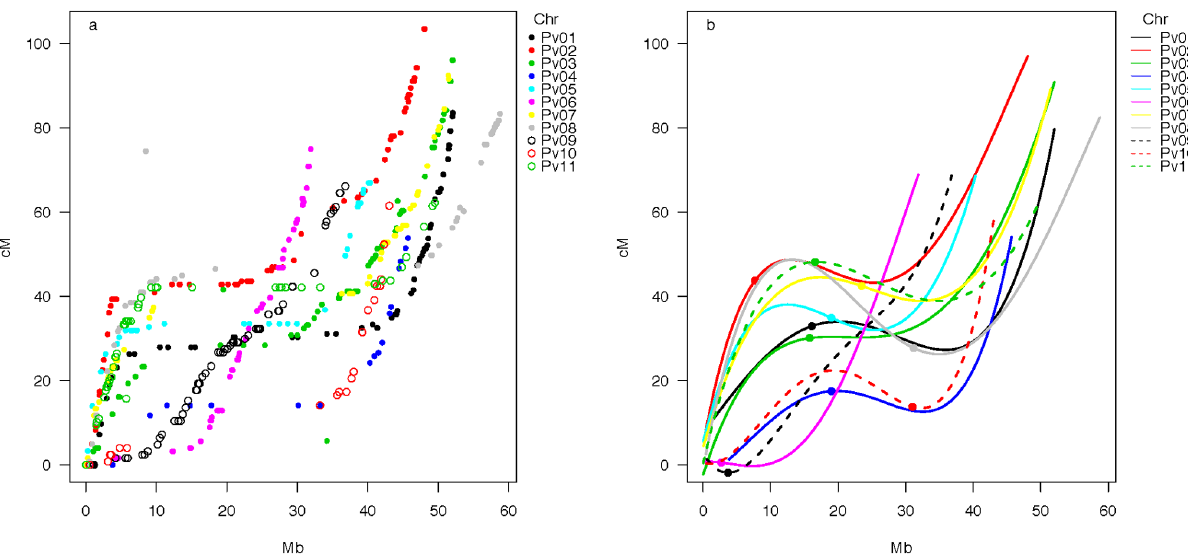
Fig 2. Correlation between linkage map distance (cM) and physical distance (Mb) for the SNP markers across each of the eleven chromosomes of common bean (Pv) showing (a) Absolute values and (b) polynomial fitted lines. Filled dots in (b) mark the centromeres according to Schmutz et al .